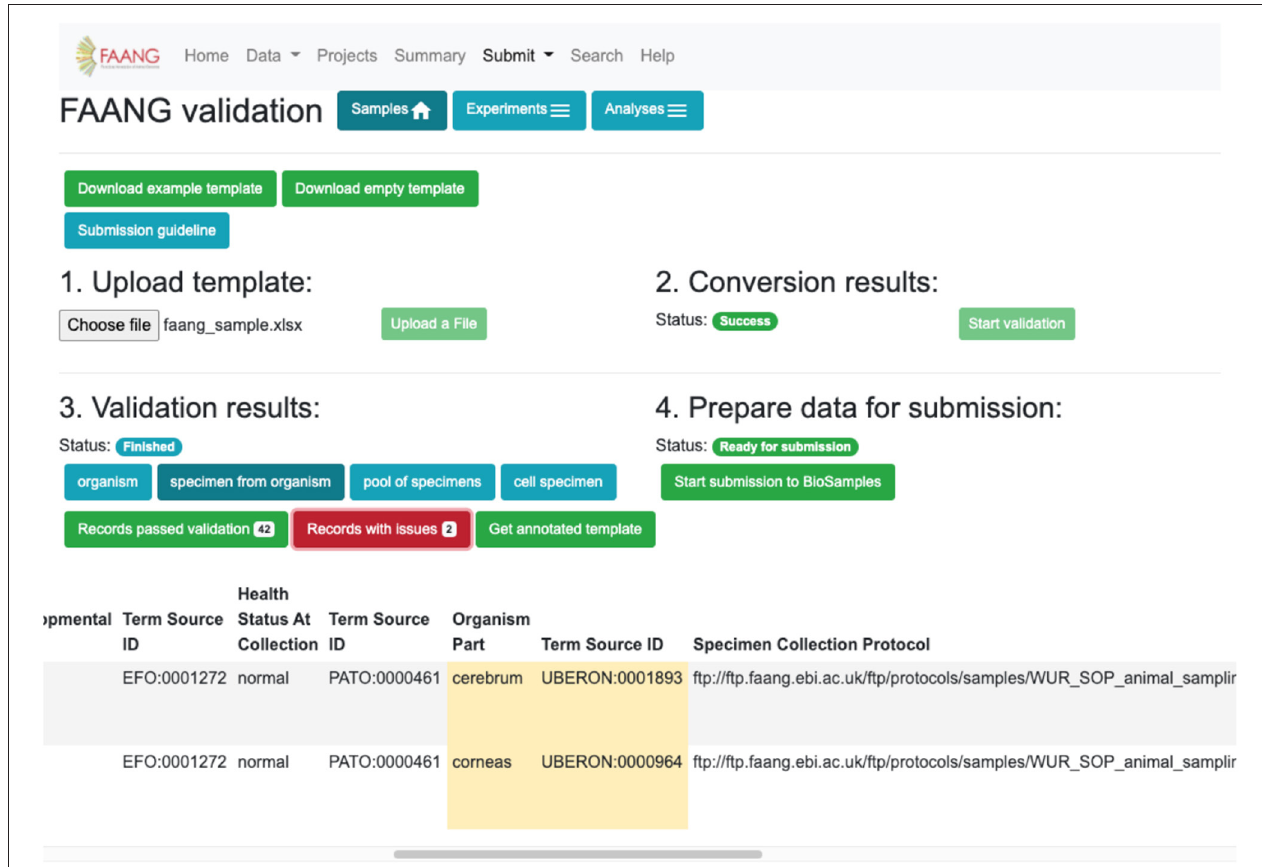
FIGURE 5 | Data validation and submission brokering service flag metadata errors and improvements for correction before submission can be made (https://data.